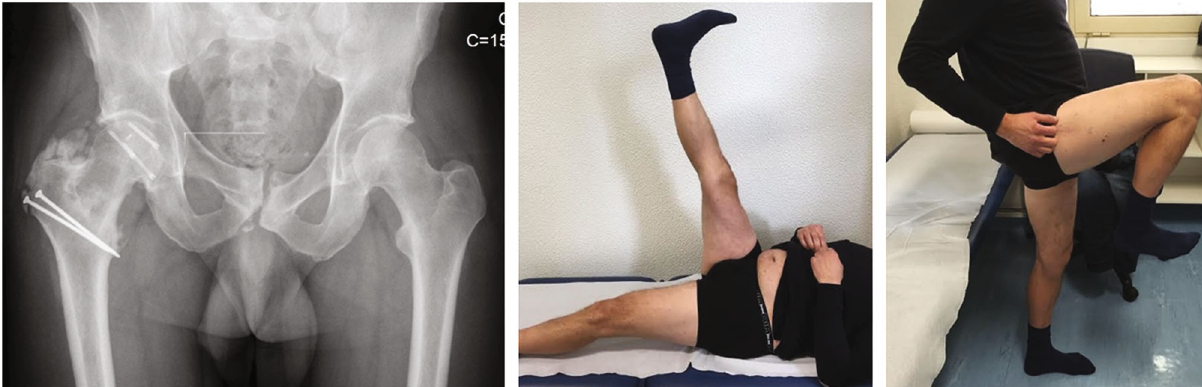
Figure 5: Simple anteroposterior radiograph showing supratrochanteric heterotopic ossi fi cation at 3 years of follow-up, with a good active motion of the hip and painless hip fl exion.